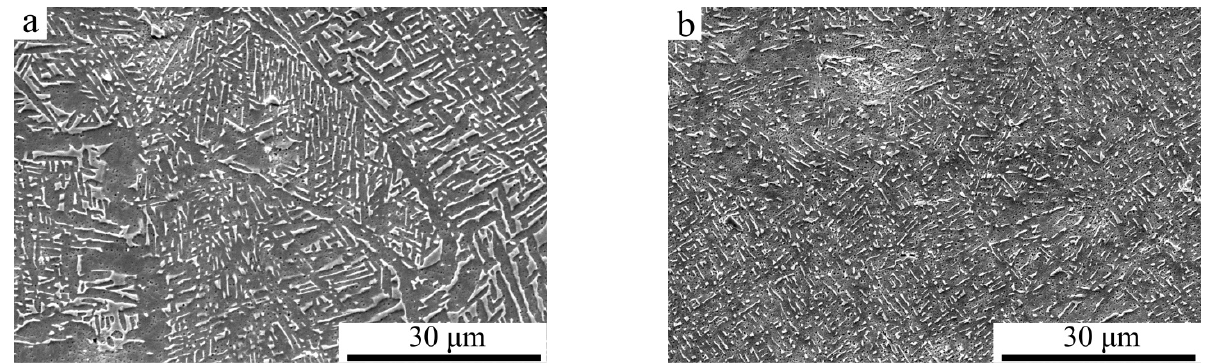
Figure 4. SEM microstructure of PBF-EB AM Ti6Al4V: ( a ) linear scanning strategy (sample A), ( b ) linear and 90° rotate scanning strategy (sample B).